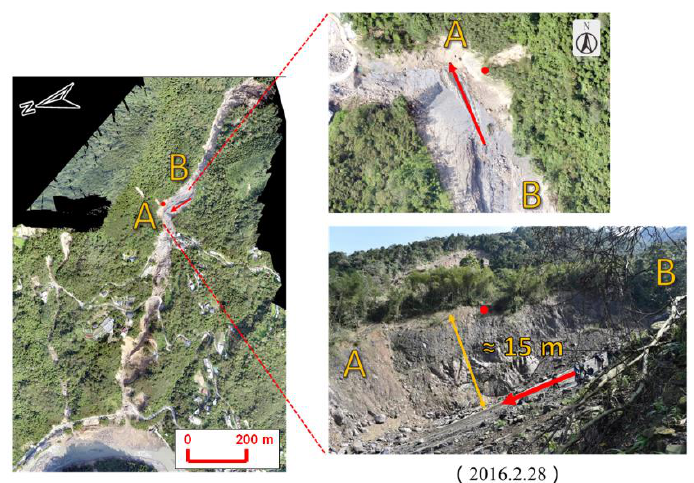
Figure 1. Location of the Zhongzhi landslide and the cataclinal slope [3].